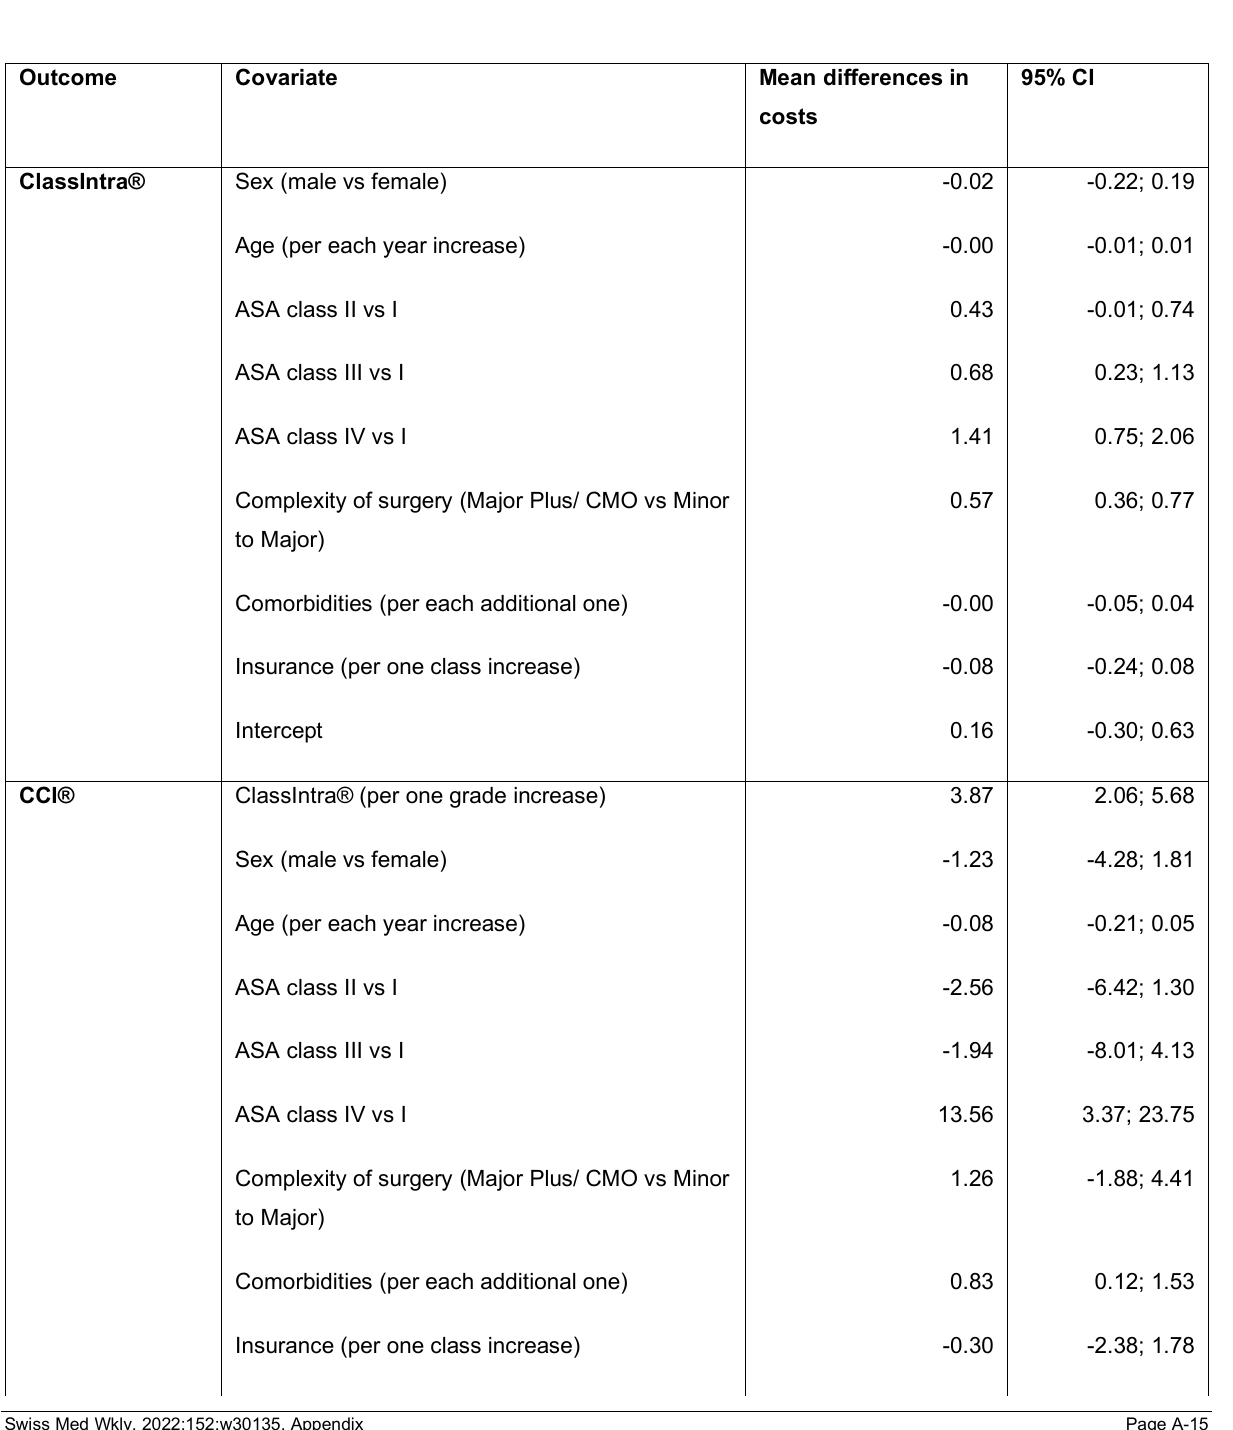
Table 3: Complete reimbursement model with full output (in Euros) Structural equation model including all patients (n=320) showing total effects of fixed patient characteristics and hospitalisation-related parameters on total hospital reimbursement. Patient characteristics were considered as exogenous variables while hospitalisation-related parameters were considered both as potential mediators of causal effects and as sources of causal effects in their own